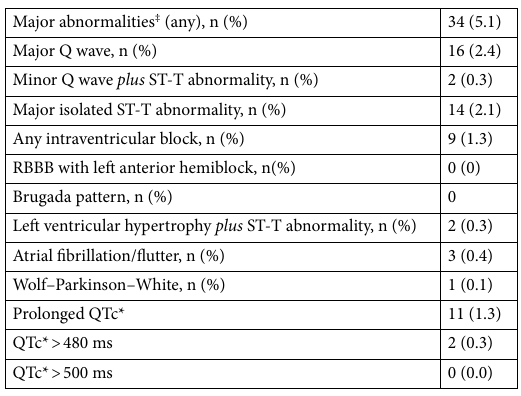
Table 2. De novo major abnormalities at follow-up. RBBB right bundle branch block. ‡ Any participant may have more than one major abnormality. *Corrected using Bazett’s formula (QT/√RR).